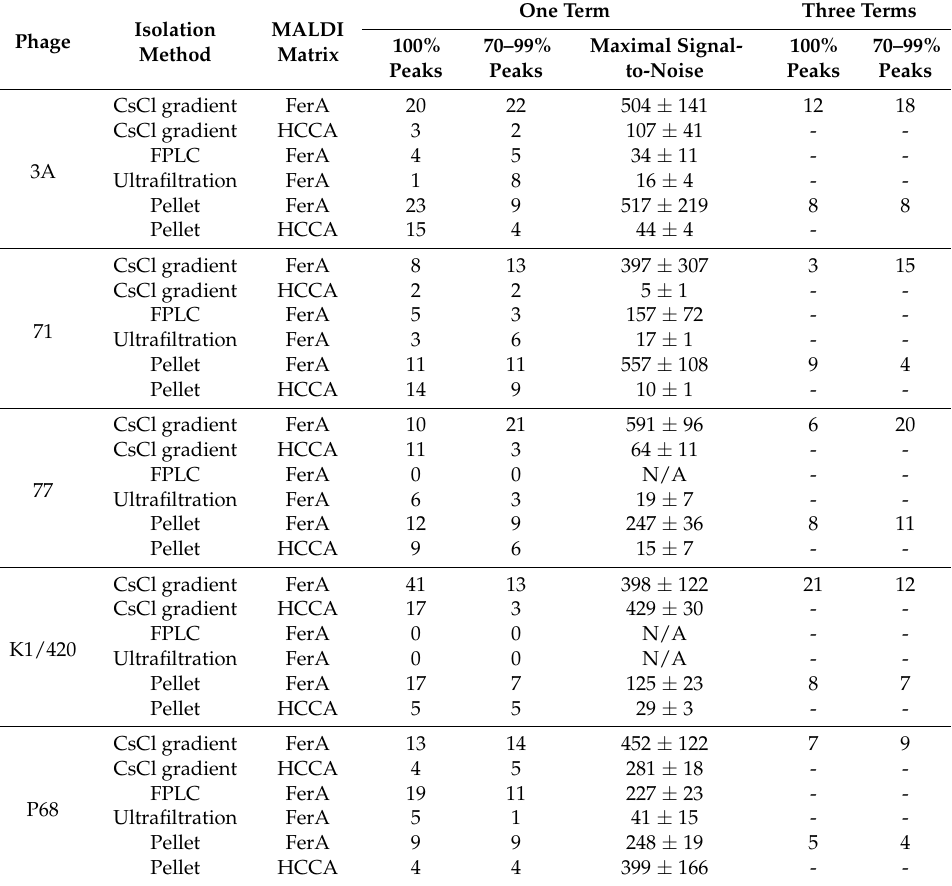
Table 2. Evaluation of the mass spectral quality in terms of signal reproducibility (peaks detected in 100% or 70–99% of mass spectra acquired for each sample) and signal-to-noise ratio of the most intense peak when using five different isolation methods and two matrix-assisted laser desorption ionization (MALDI)